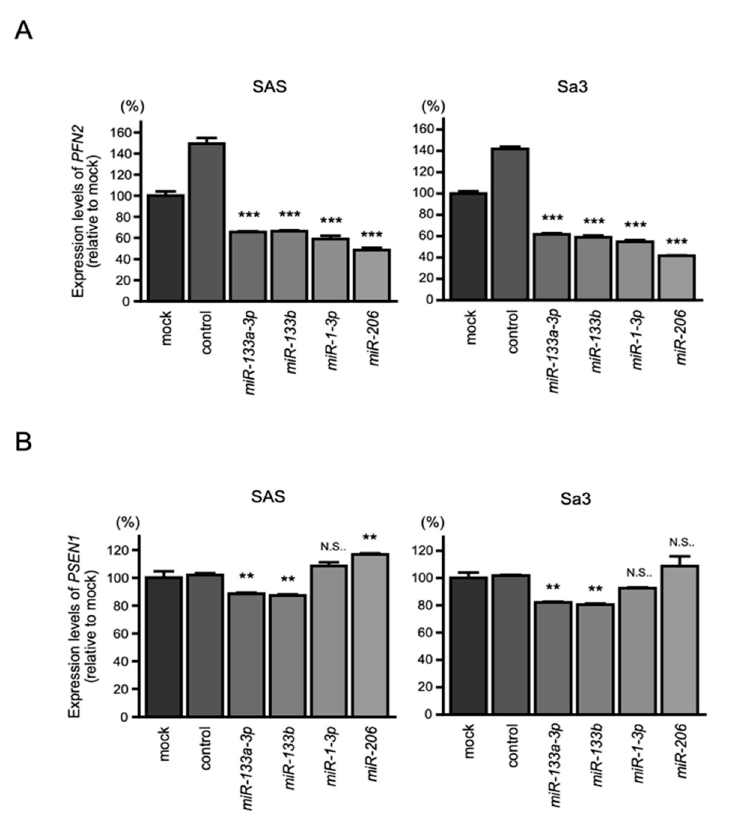
Figure 5. Expression of PFN2 and PSEN1 controlled by miR-1 / miR-133 clustered miRNAs in HNSCC cells: ( A ) real-time PCR showed significantly reduced expression of PFN2 mRNA 48 h after transfection of each miR-133a-3p / miR-133b and miR-1-3p / miR-206 ; ( B ) PSEN1 expression was not repressed by miR-1-3p / miR-206 . (** p < 0.01, *** p < 0.001, N.S.: not significant).